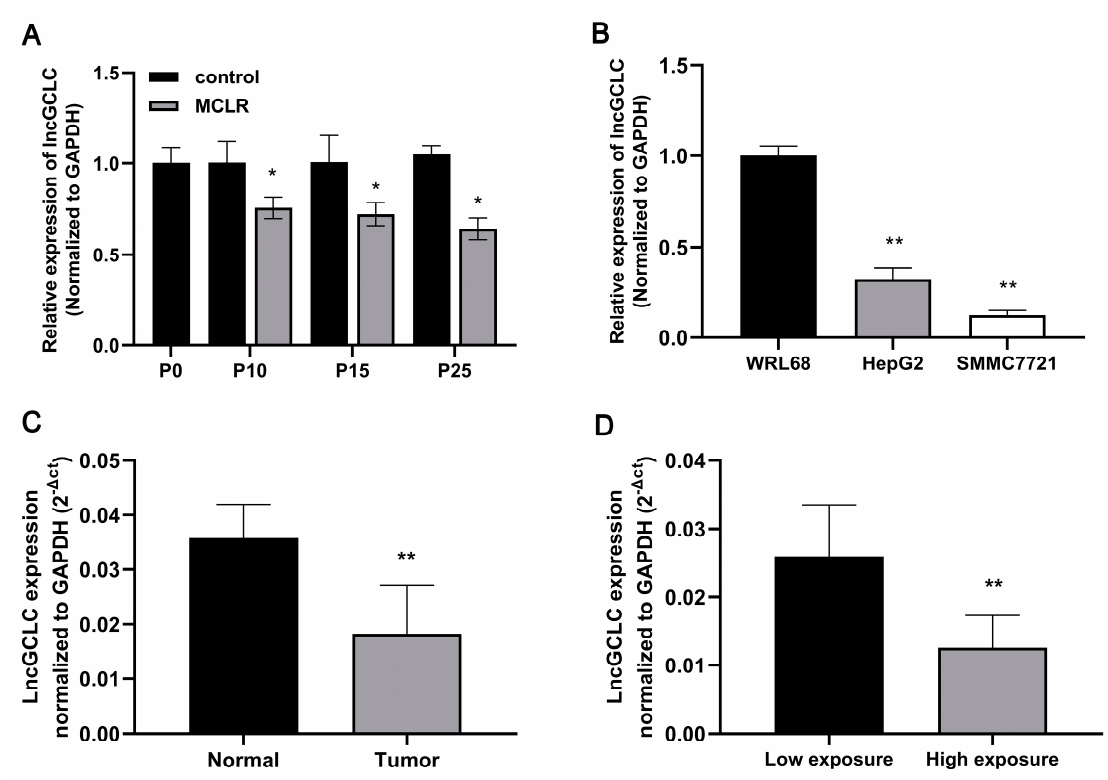
Figure 1. The lncGCLC expression in MCLR-exposed cells and population samples. ( A ) Changes of lncGCLC expression in WRL68 cells after exposure to 0 or 10 µ g/L of MCLR for 0, 10, 15, and 25 passages. * p < 0.05 compared with passage-matched control cells. ( B ) Comparison of lncGCLC expression in WRL68, HepG2, and SMMC7721 cells. ** p < 0.01 compared with WRL68 cells. ( C ) Comparison of lncGCLC expression in tumor tissue and adjacent normal tissue from HCC patients with MC exposure (n = 30), ** p < 0.01. ( D ) LncGCLC expression in HCC patients with high MC exposure (serum MCs ≥ 0.14 µ g/L, n = 17) was lower than that in those with low MC exposure (serum MCs < 0.14 µ g/L, n = 13), ** p < 0.01. Data are presented as the mean ± SD of three independent experiments.